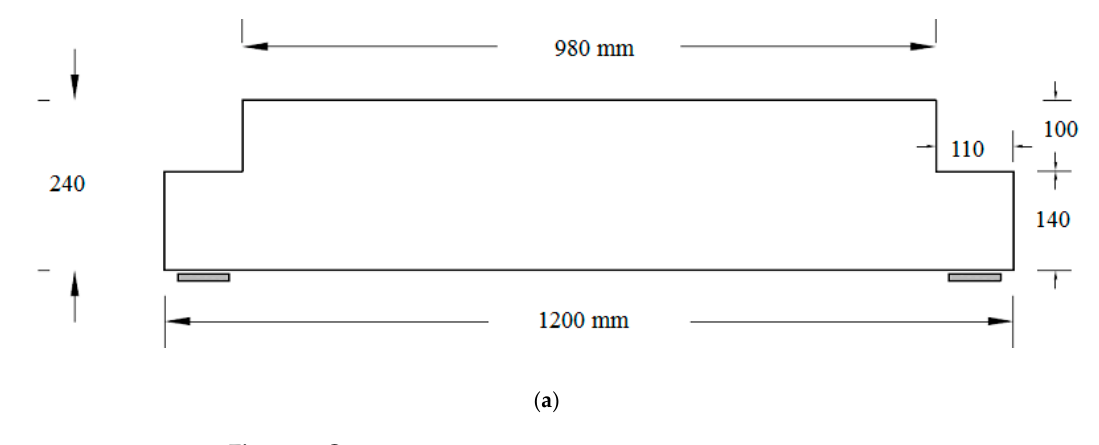
Figure 2. Section layout details and numerical modelling of typical RC girders with dapped ends. ( a ) Geometry layout [39]. ( b ) Details of the reinforcements in the previous experimental investiga- tions [39]. ( c ) 3D view of the numerical model for the reinforcement details.